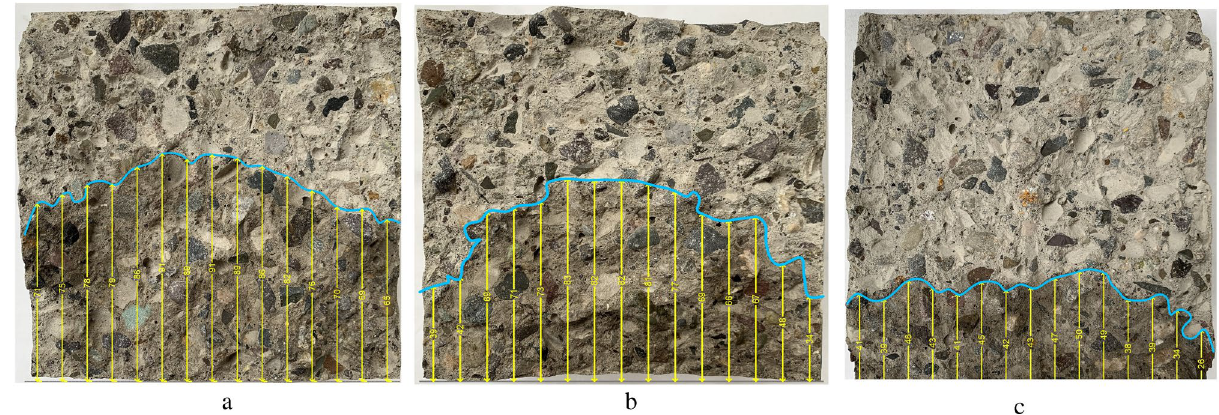
Figure 11. Water penetration area and penetration front in ( a ) RHAC20, ( b ) NSC8, and ( c )